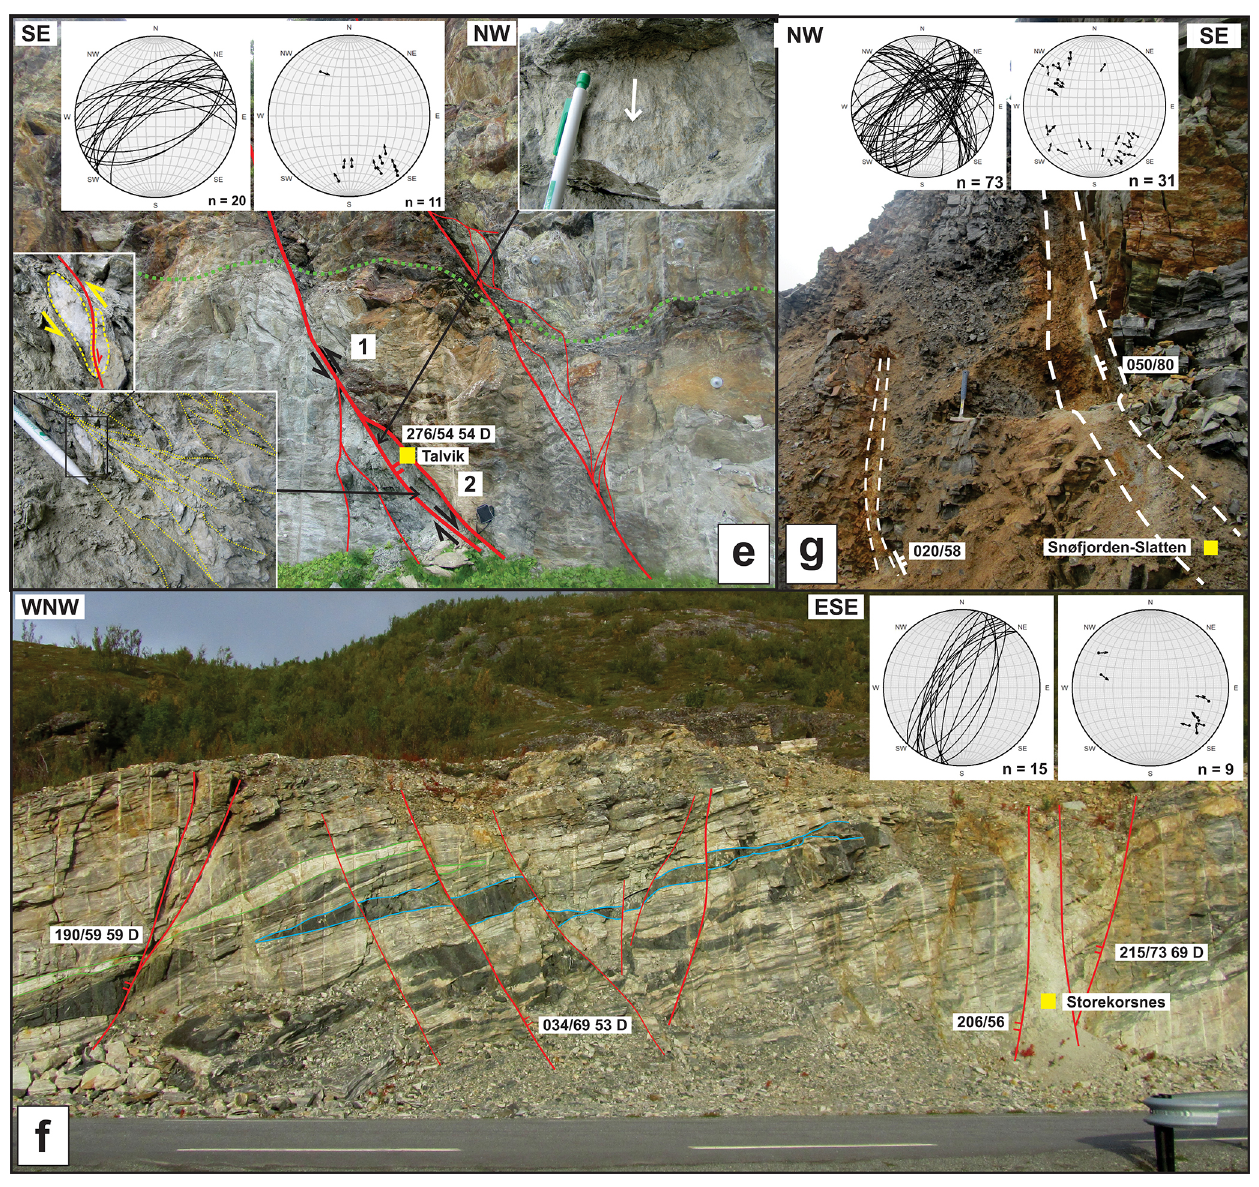
jacent to a lens of preserved Magerøya Nappe rocks on